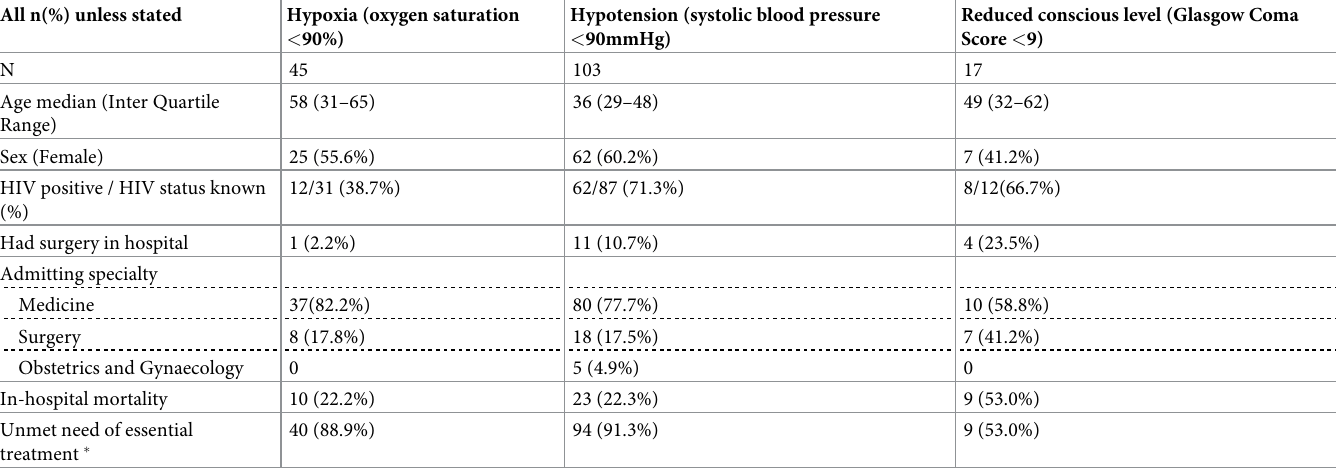
Table 1. Participant characteristics, in-hospital mortality rates and the unmet need of essential treatments, by deranged vital sign. All n(%) unless stated Hypoxia (oxygen saturation Hypotension (systolic blood pressure < 90%) < 90mmHg)